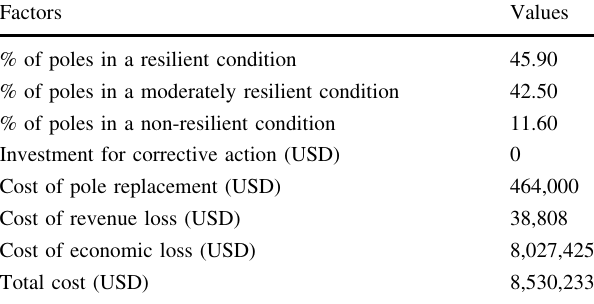
Table 8 Results for Strategy